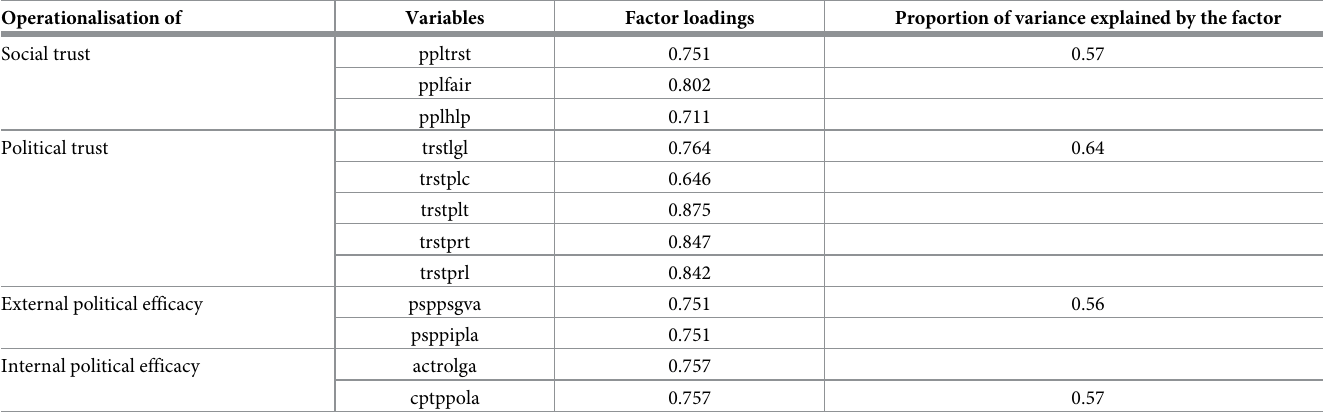
Table 2. Operationalisation of social trust, political trust, external and internal political